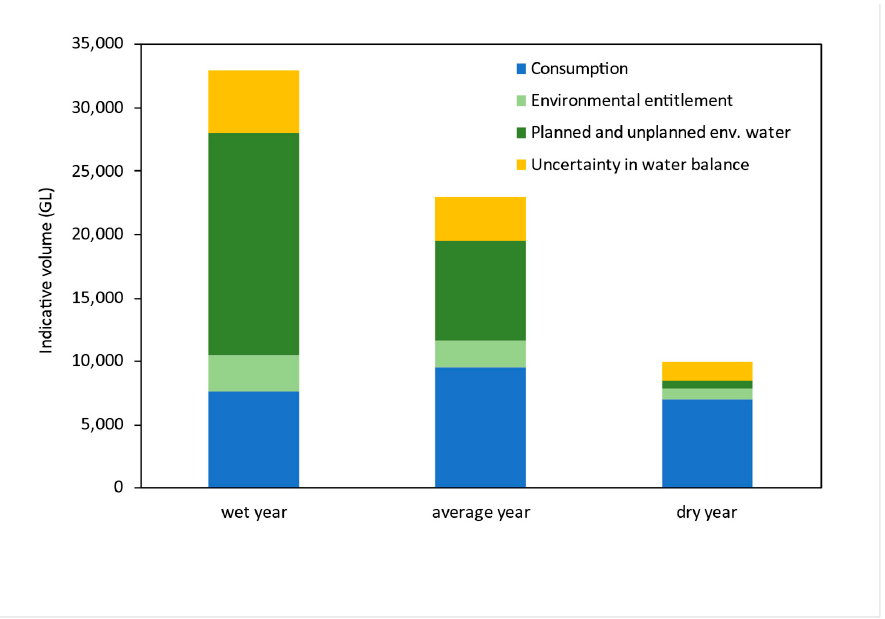
Figure 4. Indicative volumes of water in the Basin in wet, average, and dry years in the Basin. Volumes are subdivided into water consumption, water allocated under environmental entitlements, remaining water available to the environment, and uncertainties in the water balance (which may or may not be available to the environment). Based on data from [53,55,56].